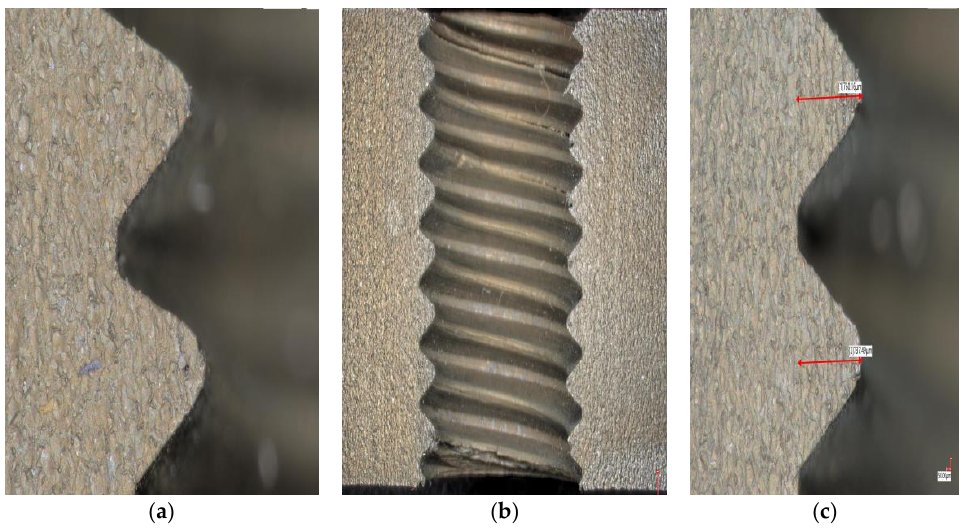
Figure 12. Contrast of tooth shape before and after optimization of process parameters ( a ) Tooth shape before optimization, ( b ) Optimized extrusion effect, ( c ) Optimized tooth shape.